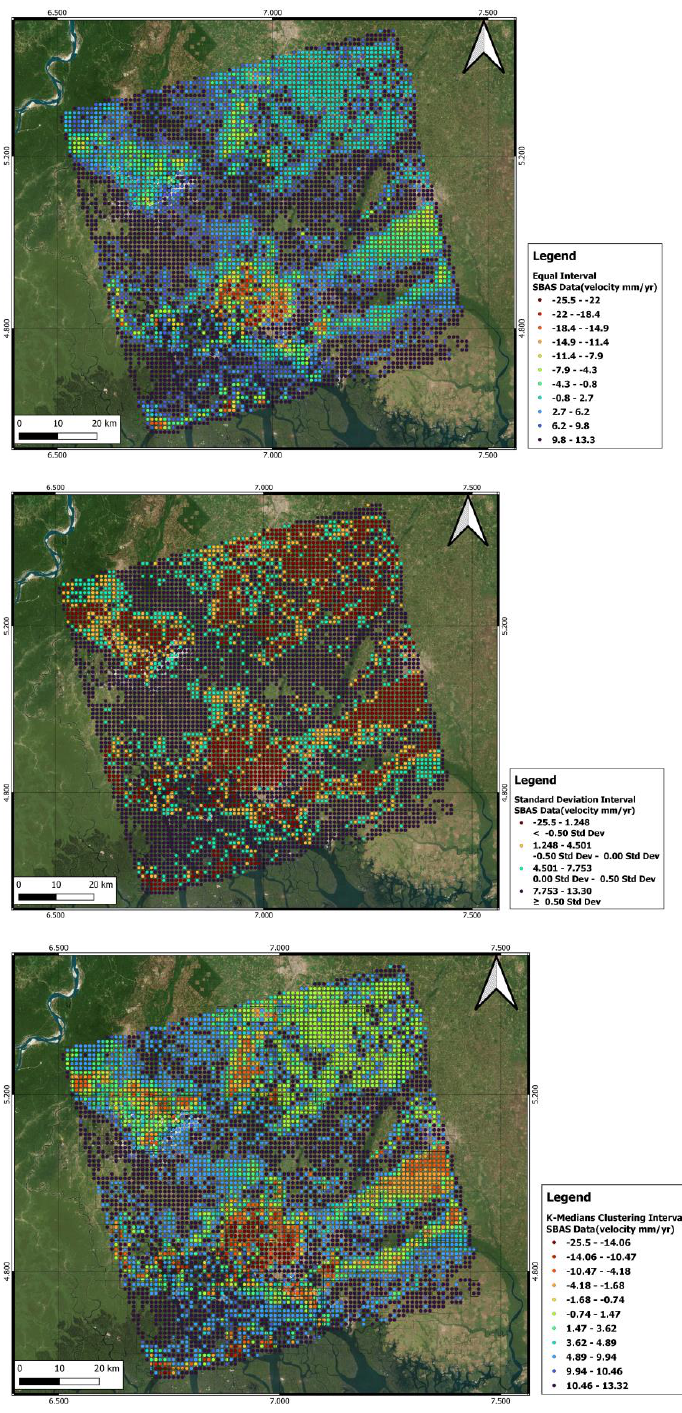
Figure 14. Comparison means displacement rate maps from SBAS techniques, including the ( up ) equal interval method, ( mid ) STD method, and ( down ) K-medians clustering algorithm.